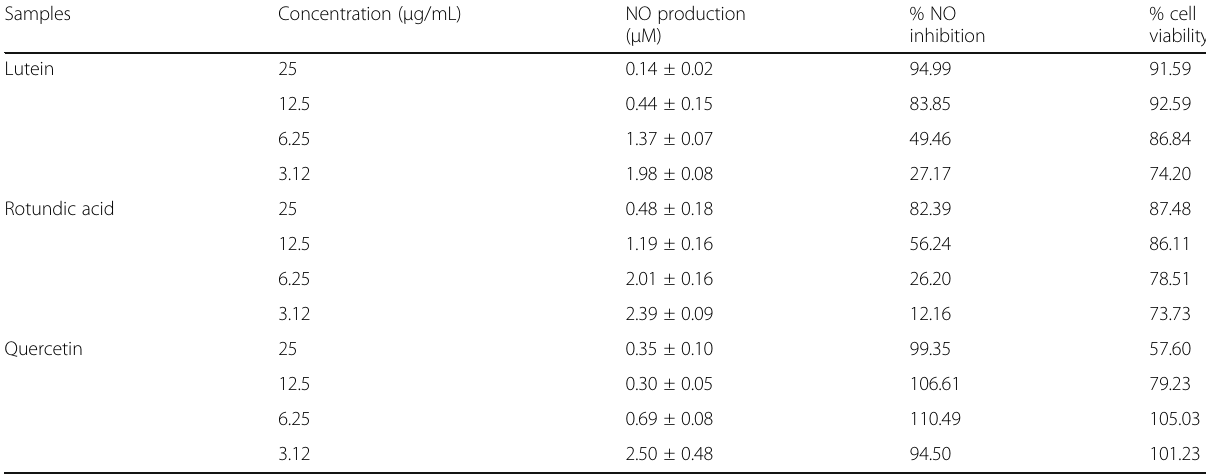
Table 4 Inhibitory activities of compounds on NO production in LPS-activated RAW 264.7 macrophages